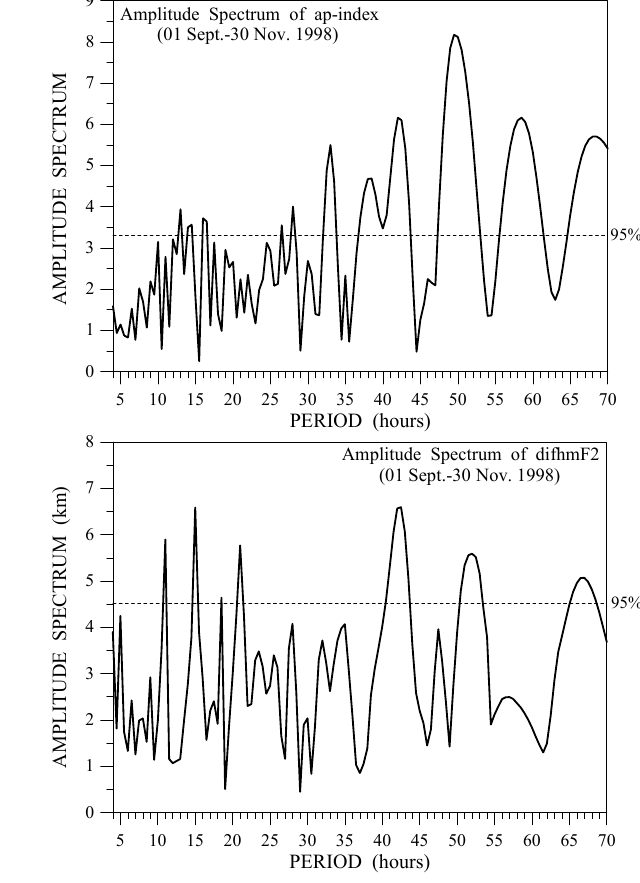
Fig. 12. Description of the geomagnetic storms in: (a) September 1998 and (b) in November 1998 by hourly D st -index